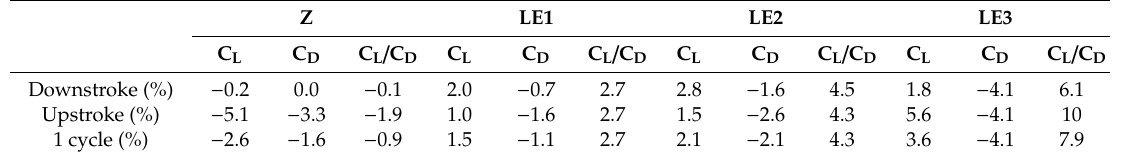
Table 1. Changes in the average lift coe ffi cients (C L ), drag coe ffi cients (C D ), and gliding ratios (C L / C D ) of the Z, LE1, LE2, and LE3 wings, compared to those of the S wing, at r = 0.375 R